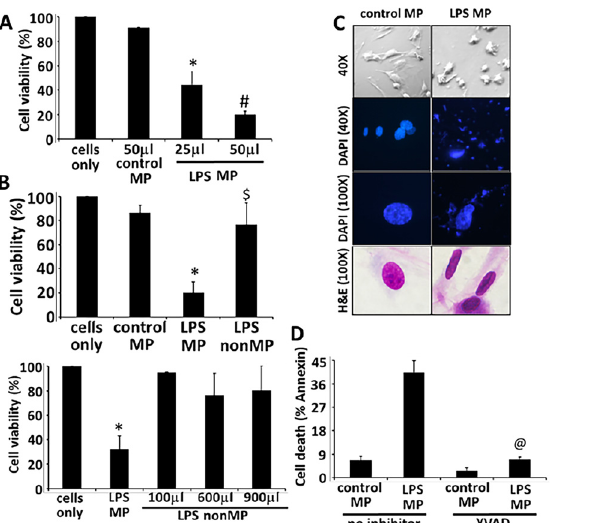
and supernatants were separated into microparticle (MP) and non- microparticle (nonMP) fractions by serial centrifugations. HPMVECs were co-cultured with these MP and nonMP fractions and analyzed for cell viability and apoptosis. Cell viability was measured by MTS assay (A and B) and morphology using DAPI staining (C). HPMVECs were then treated with microparticles isolated from unstimulated or LPS